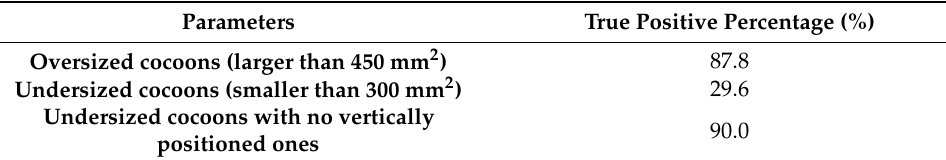
Figure 6. ( A ) Regular cocoon, ( B ) defective shape, ( C ) incorrect size due to positioning, ( D ) stained at the top (large orange spot), ( E ) stained at the bottom (black spot). Table 2. The true positive percentage (defective cocoons marked as such).